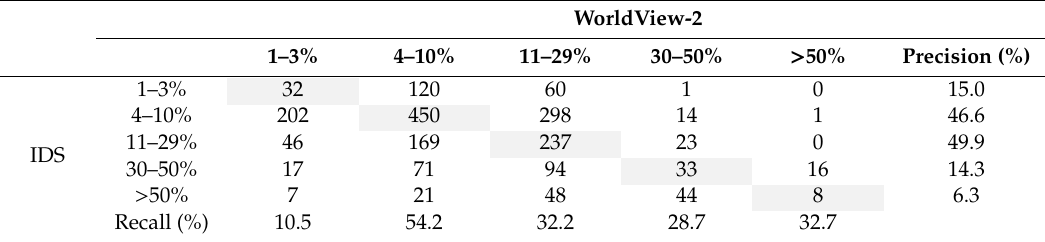
Table A3. Comparison of percent tree mortality area derived from 2018 WorldView-2 and IDS polygons (2014–2018 cumulative). Values in matrices are counts of IDS polygons. IDS trees per acre measurements were converted to percent mortality using the FHAAST method. Overall accuracy = 37.8%, N = 2012.